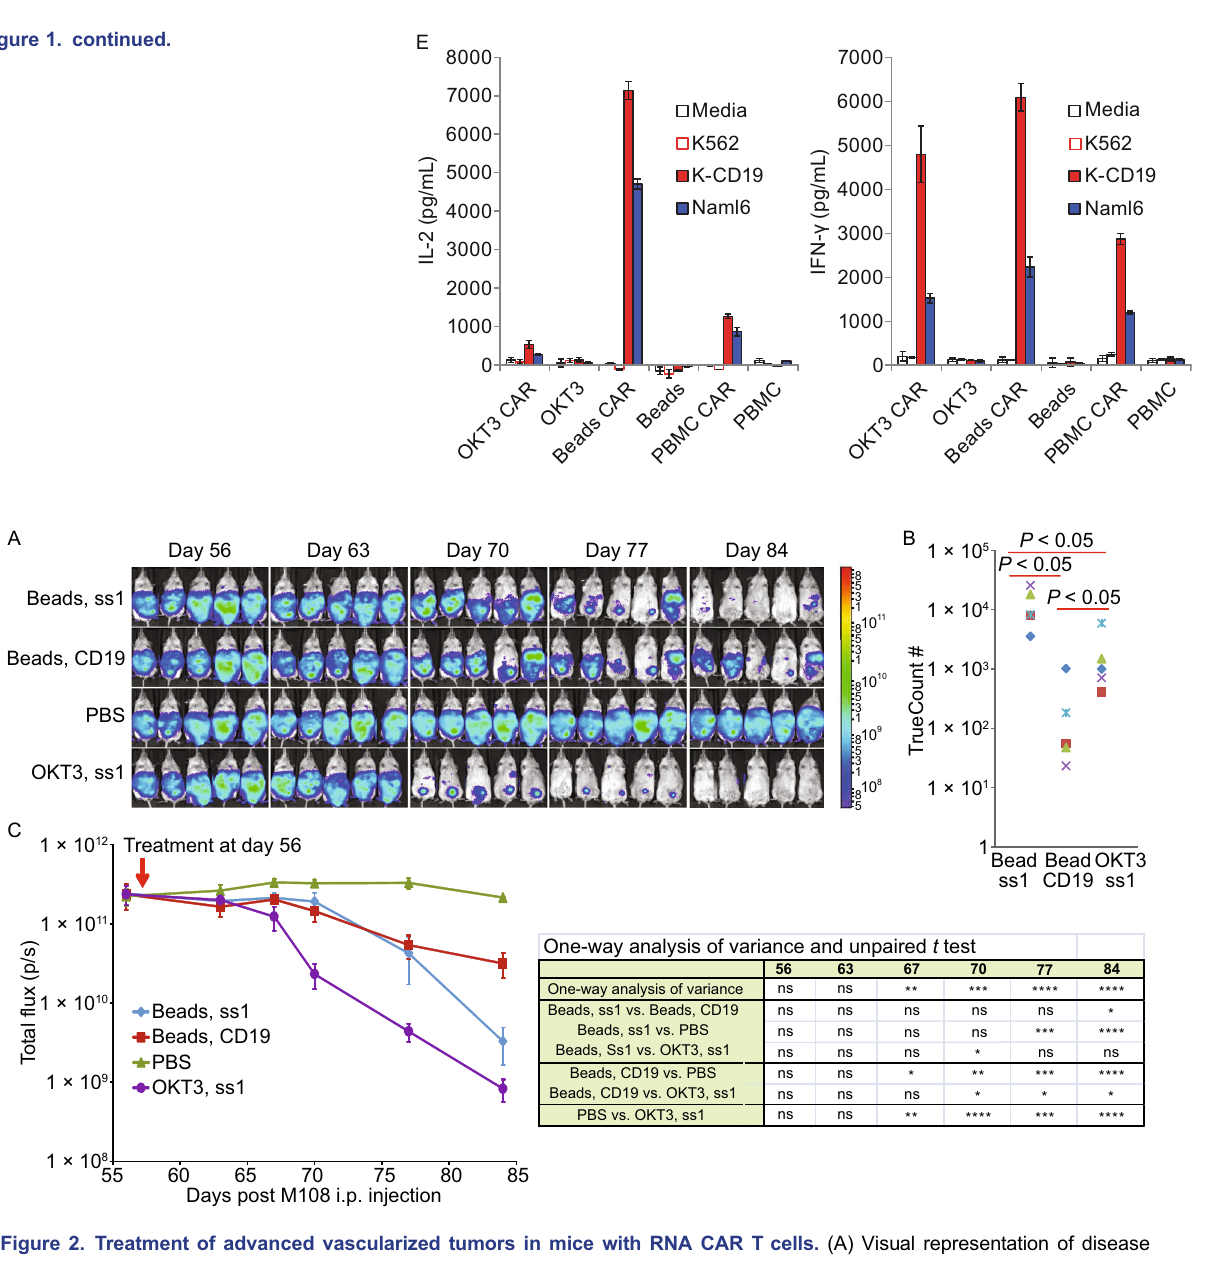
Figure 2. Treatment of advanced vascularized tumors in mice with RNA CAR T cells. (A) Visual representation of disease burden in mice with an M108 tumor treated with expanded Tcells. Disseminated intraperitoneal (i.p.) tumors were established in NSG mice ( n = 5 per group) via injection with 8 × 10 6 M108-Luc cells. Beginning on day 56, a single dose of RNA CAR-electroporated T cells (2.5 × 10 7 ) was injected (i.p.). (B) Detection of human T cells in the peripheral blood of treated mice 40 days post-treatment. Human CD45 + cells were detected using a Trucount fl ow assay. (C) BLI data and statistical analysis for the experiment. Bars, SE. A greater reduction in disease burden was noted in the mice treated with T cells expanded with OKT3 and expressing ss1BBZ CAR compared with all other